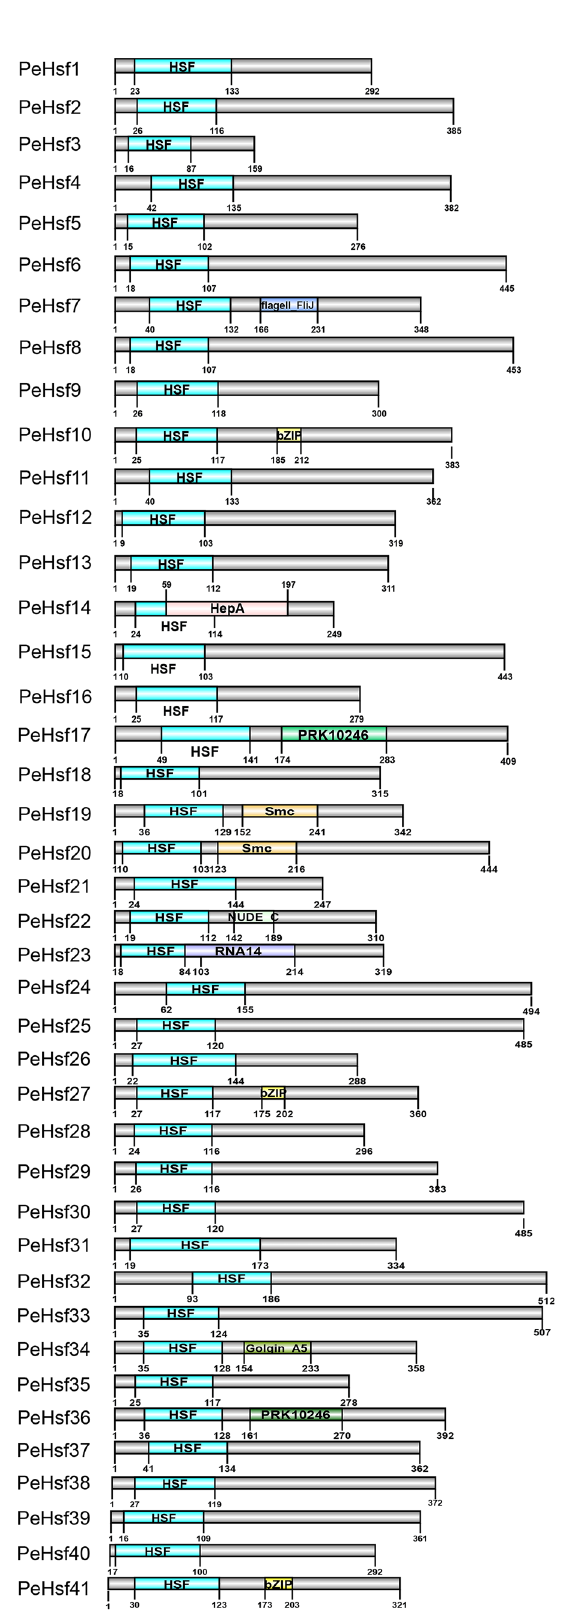
Figure 5. Conserved domain predictions for 41 PeHsf proteins. The gray bars represent the length of each protein sequence, and conserved domains are represented by colored boxes. DOG 2.0 (http:// dog. biocu ckoo. org) was used for protein structure visualization with default